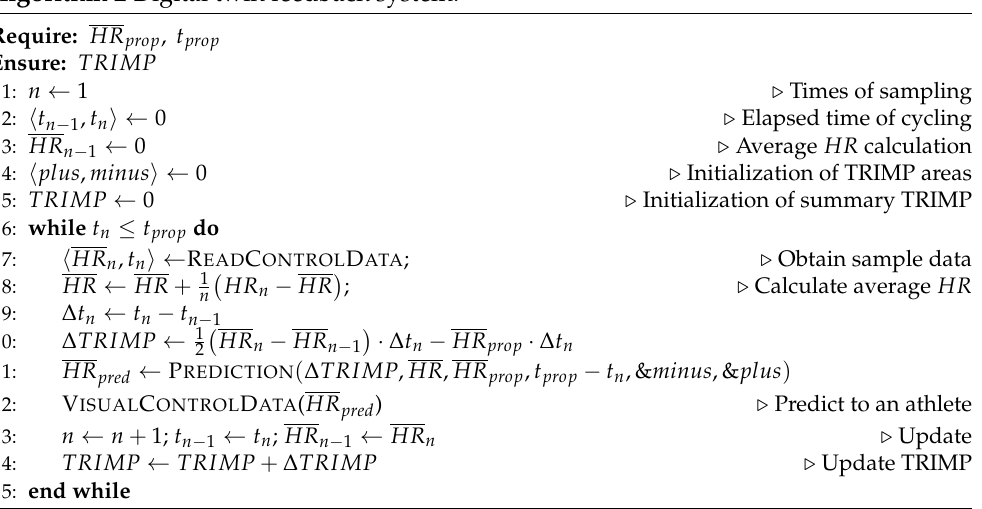
Algorithm 2 Digital twin feedback